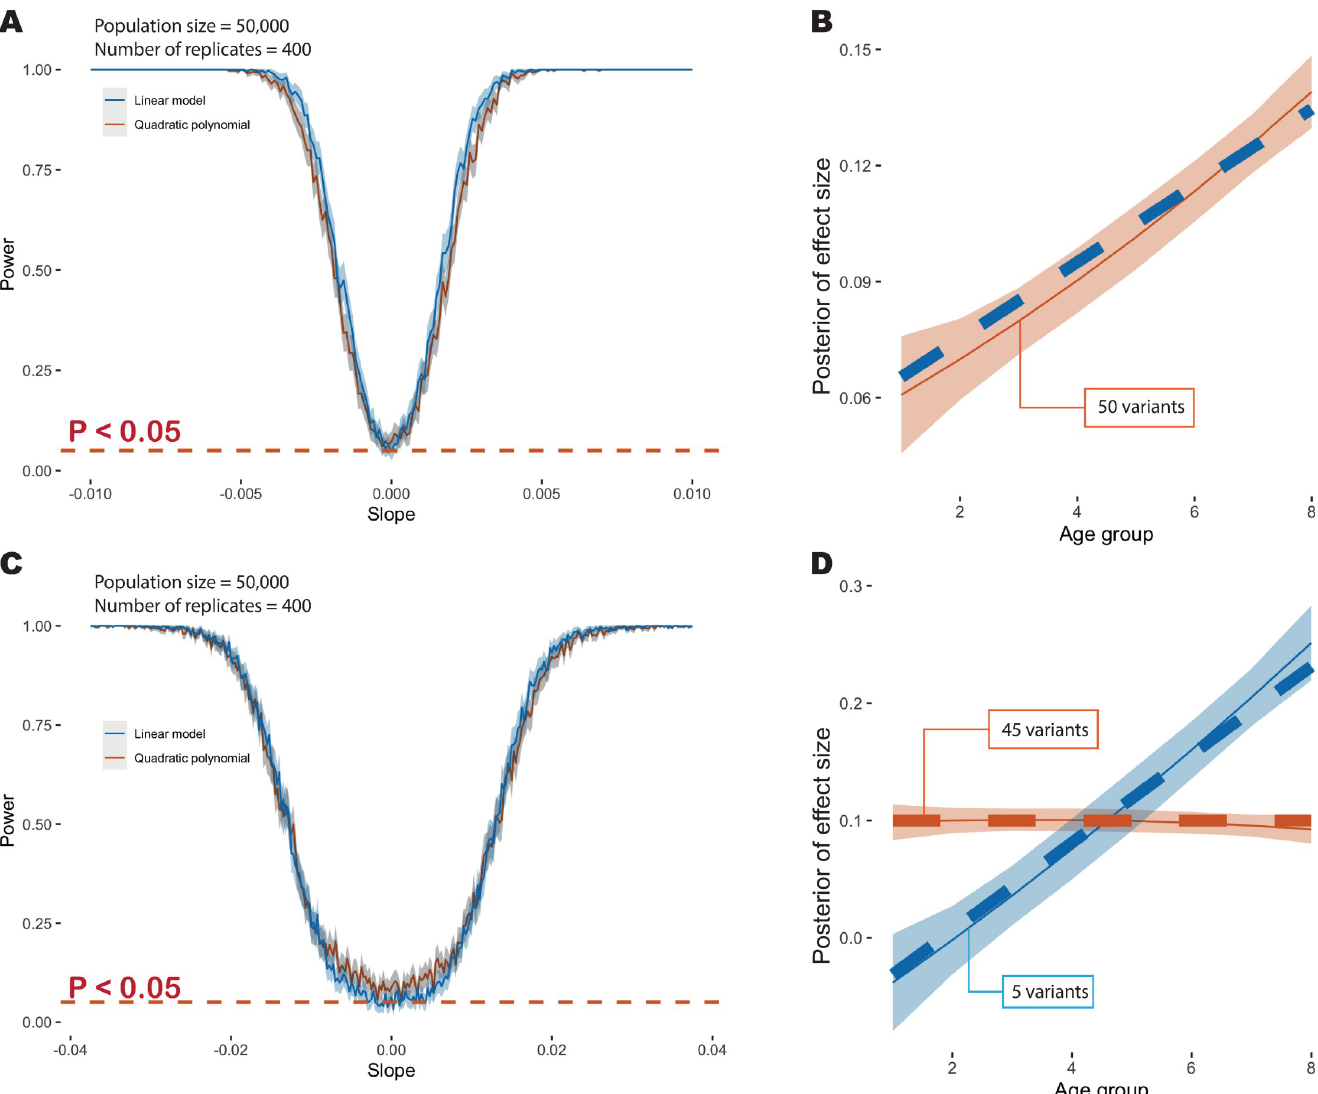
Fig 3. Overview of simulation results. (A) Power at P � 0.05 to detect deviation from age-homogeneity as a function of slope in a model where effect sizes change linearly with age. The blue line indicates the point estimate when using a linear model to fit, the red line indicates the point estimate with a quadratic polynomial model and the grey shading indicates the 95% confidence interval. (B) Example showing the age-profile under which data are simulated (dashed blue line) and the inferred age profile (dashed red line) and 95% credible interval (red shading). (C) Power at P � 0.05 to detect multiple age profiles in a simulation where 90% of variants have a time-invariant profile and 10% have an effect size that increases with age. The solid blue line indicates power when fitting a linear model and the solid red line indicates power when fitting a quadratic model. The dashed red line indicates the nominal significance threshold. Note the change in x-axis scale compared to Fig 2A. (D) Example showing inferred age-profiles for the two components (mean posterior and 95% credible interval). Additional simulation details are provided in the S1 Supplemental Methods and S2 Fig.